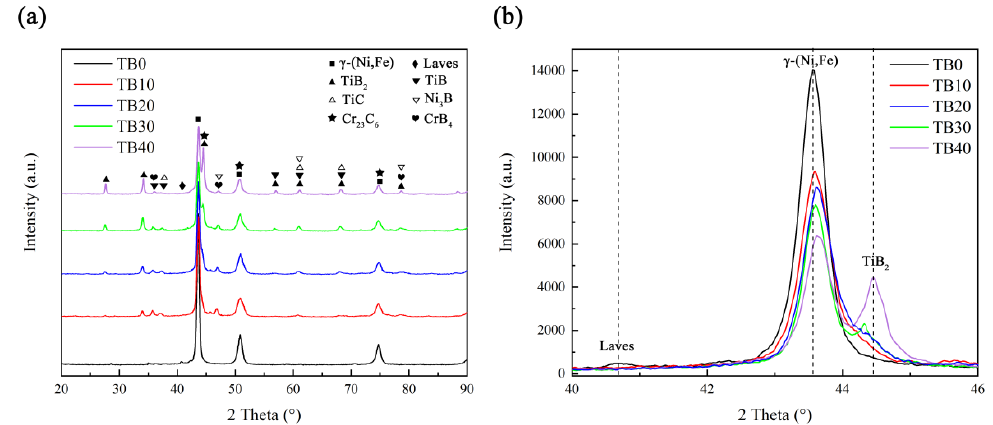
Figure 5. XRD patterns of coatings with different TiB 2 particles content when the diffraction angle is between ( a ) 20°–90° and ( b ) 40°–46°.